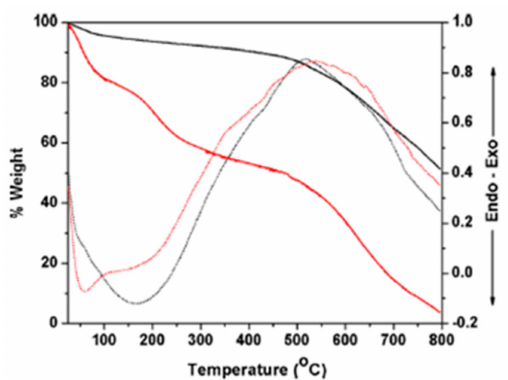
Figure 7. TGA and DTA traces of neat (black lines) and sulfonated POPs (red lines). Reproduced with permission from [61]. Copyright 2015, WILEY-VCH Verlag GmbH &